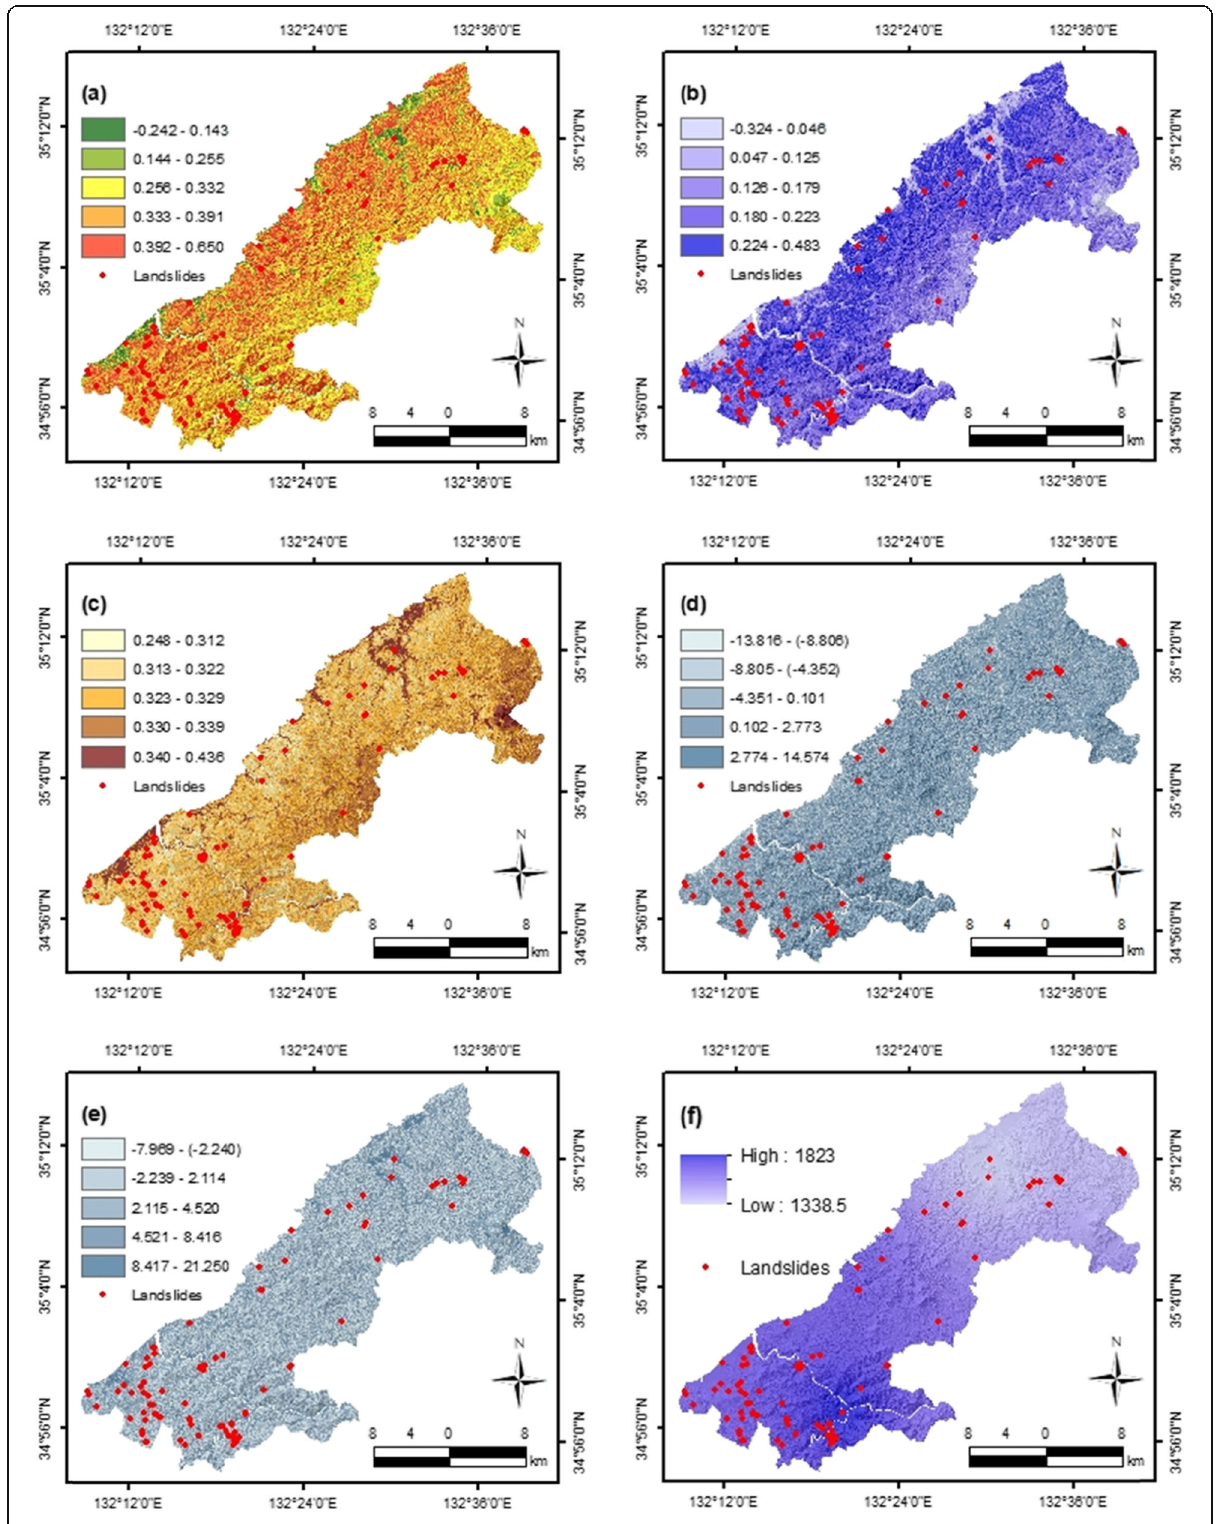
Fig. 4 Thematic maps of remote sensing - derived index ( a-c ) and hydrological factors ( d-f ) considered in this study: a NDVI, b NDWI, c BI, d SPI, e TWI, and f cumulative rainfall from March to October in 2013